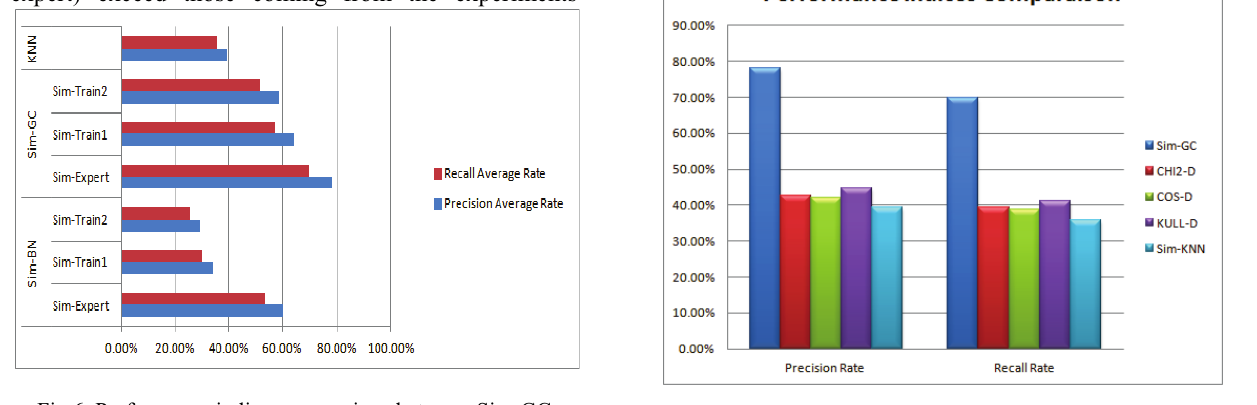
distancesFig.6. Performance indices comparison between Sim-GC, Sim-BN and